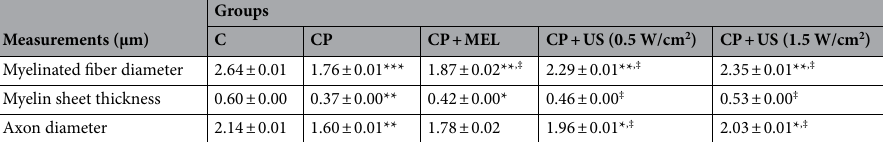
Table 4. The results of the alterations in axon diameter, myelin sheath thickness and myelin fiber diameter in the experimental study groups. The data were represented as mean ± standard error of mean. Differences in between variances were compared by One-way ANOVA test with Tukey’s test applied as a post-hoc test. P -values equal or less than 0.05 were considered as statistically significant (* p < 0.05, ** p < 0.01, *** p < 0.001). The degree of significance was symbolized by an asterisks (*) for the comparison of all groups with respect to the control group; by a double daggers (‡) for the comparison of the treatment groups with respect to the cisplatin administered group; by a daggers (†) for the comparison of ultrasound treated groups with respect to the melatonin administered group and by a section (§) for the comparison of 1 MHz 1.5 W/cm 2 US treated group with respect to the 1 MHz 0.5 W/cm 2 US treated